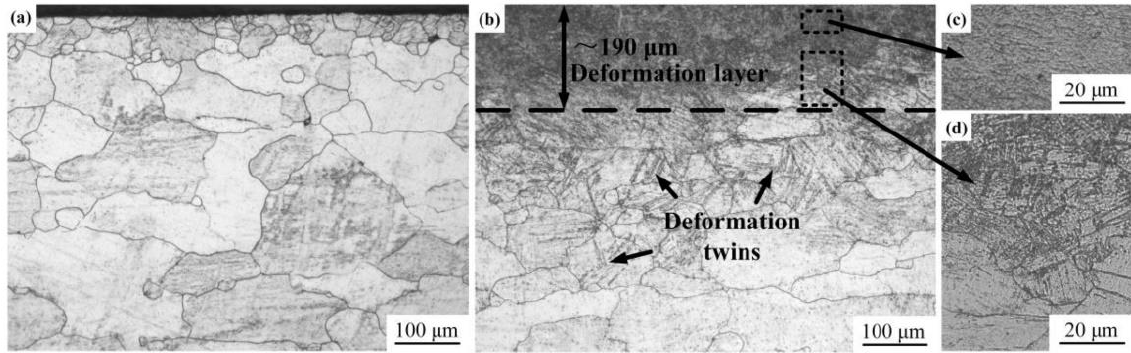
Figure 9. OM images of ( a ) untreated specimen, ( b ) USRP’ed specimen, ( c ) deformation layer ( d ) transition zone. Reprinted with permission from ref. [68]. Copyright 2020 MDPI.